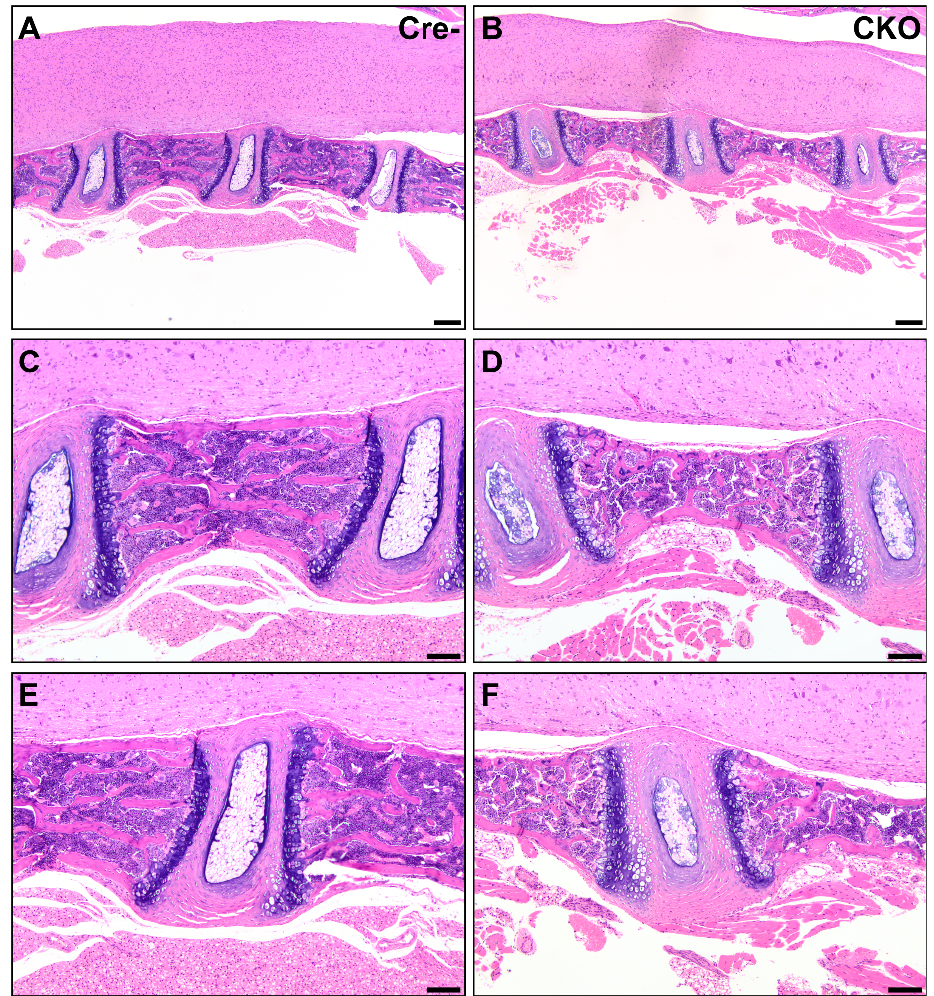
Figure 5. Reduced soft and mineralized tissue in CKO vertebrae. CKO mice ( B , D , F ) had smaller vertebrae and intervertebral disks than Cre- age-matched control mice ( A , C , E ). Changes similar to those found in other bones were present in the vertebrae from CKO mice ( D ), with thinned cortices and thin trabeculae compared to comparable Cre- control mice ( C ). The intervertebral disks were also smaller in CKO mice ( F ) but had similar differentiation of the nucleus pulposus and annulus fibrosus. The cartilage end plates were comparable. Scale bars ( A , B ) = 200 µm. Scale bars ( C – F ) = 100 µm.